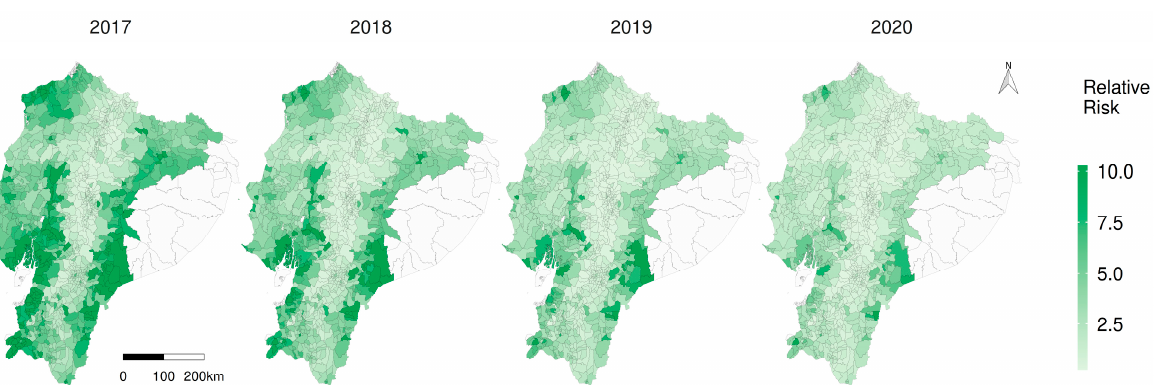
Figure 7. Spatiotemporal representation of the priority index (PI) to fight classical swine fever in Ecuador. 4. Discussion When countries mount resource-intensive control strategies for a high-impact disease such as CSF but fail to reach the goal of control and elimination, a deeper analysis of the disease dynamics and the implemented control interventions is needed to identify strategic intervention points. Despite the fact that, in general terms, many CSF risk factors are known, their relevance in the specific setting of a pig sector and the respective control program is ideally assessed using all available data. Swill feeding is one of the main risk factors for CSF transmission; it is common and rooted in the cultural tradition of backyard producers [49]. Therefore, it is very likely to be a key disease driver in endemic areas of Andean countries. The Agricultural Health Law of 2019 [50] established best practices for animal feed, but lacked specific regulations on swill. Consideration needs to be given to promoting risk-reducing practices such as heat treatment [51] and stricter regulations that prohibit the use of animal protein as a feed source for pigs.